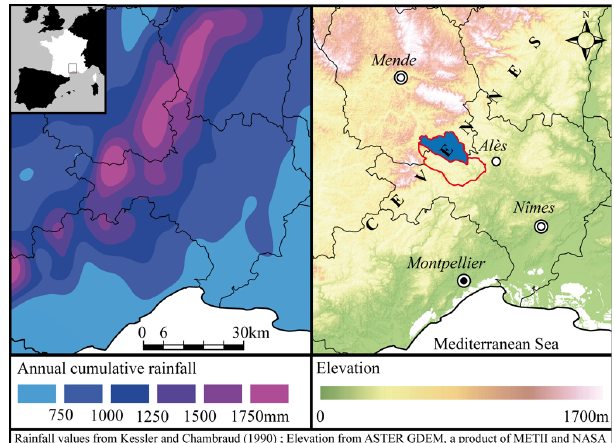
Fig. 1. Average annual cumulative rainfall (left); elevation and the Gardon d’Anduze Basin shown in the red frame. The blue zone indicates the Gardon de Mialet sub-basin (right) in the C´evennes